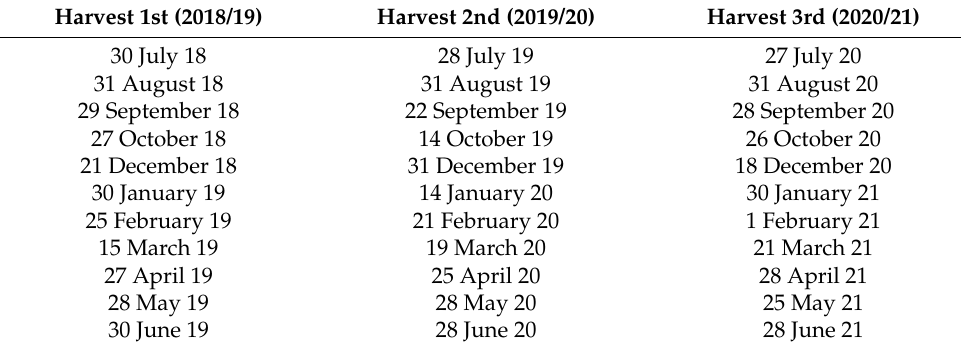
Table 1. Dates of the PlanetScope orbital images